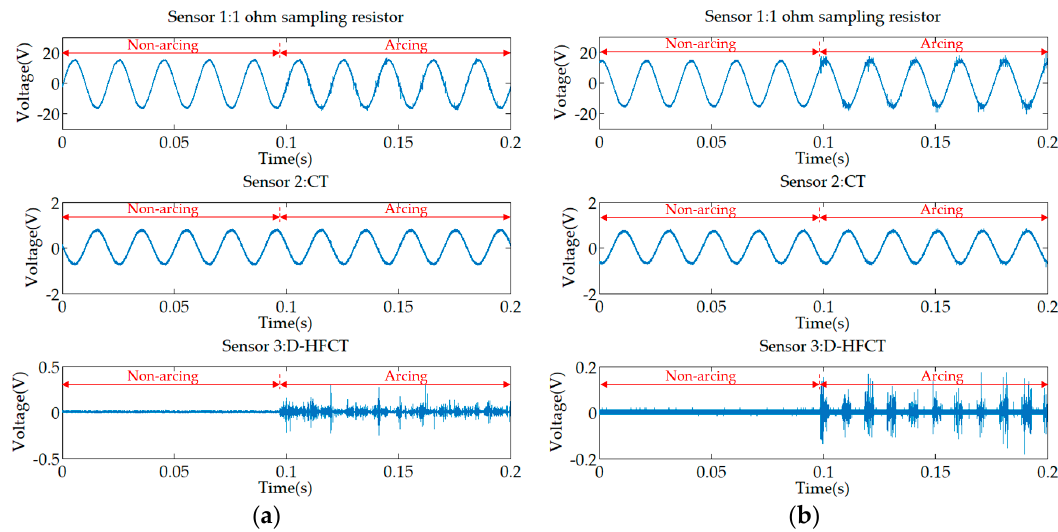
Figure 26. Adjustable resistance load box.